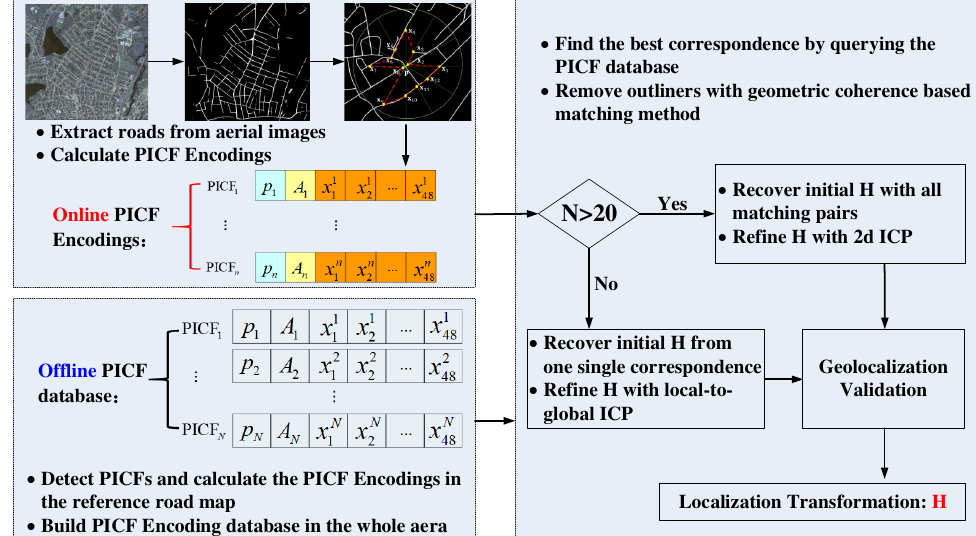
Figure 4. Overview of the proposed PICF based geolocalization method. Compared with the method in [5], the newly proposed algorithm is more sufficient, which is mainly a benefit of the good performance of the newly-designed PICF. The performance improvements come from two aspects: on the one hand, the effective encoding of the road geometric structure by the PICF, together with the effective matching method considering geometric coherence between correspondences, leads to an initial correspondences set with a high inlier ratio; on the other hand, benefiting from the good matching results (only at most one matching candidate for each feature), each recovered homography transformation can be refined, making it more robust and less sensitive to initial transformation estimation to verify whether the geolocalization is correct. Here, N is the number of obtained matching